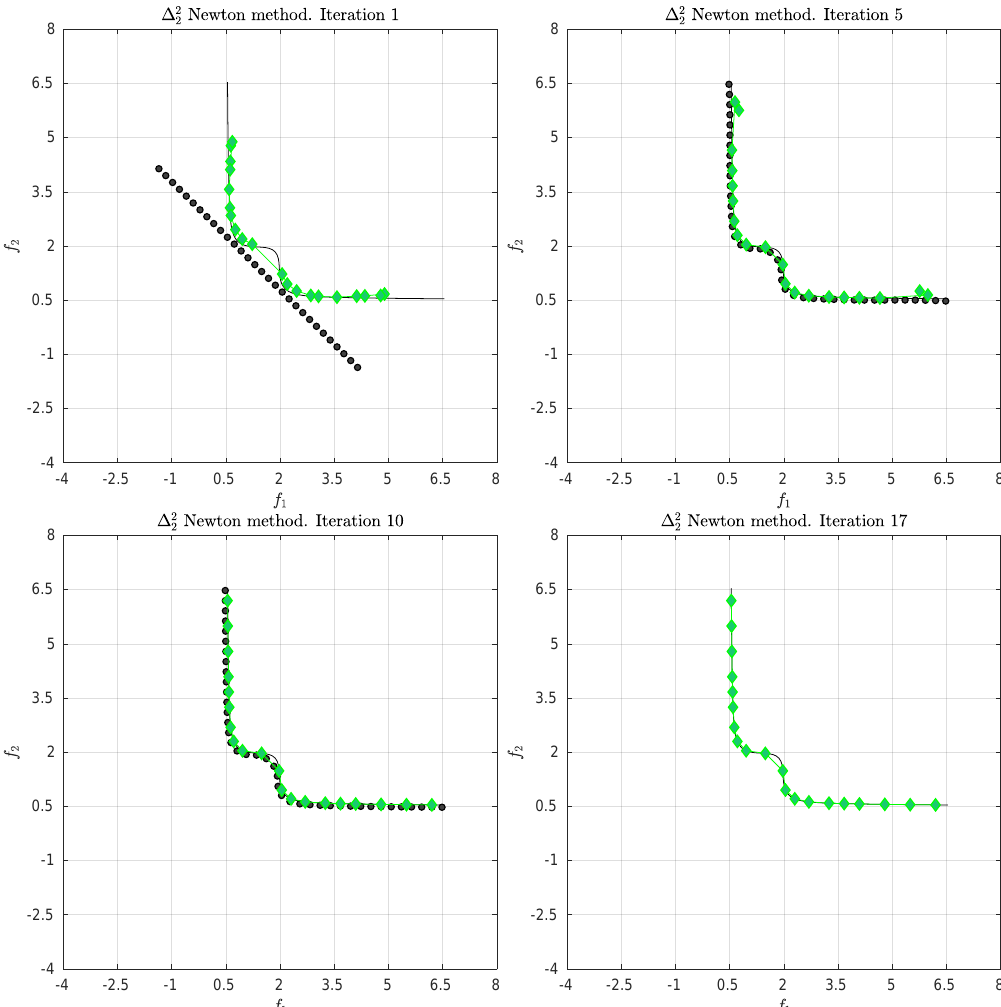
-Newton method to obtain the Pareto front of MOP (51) via the 2